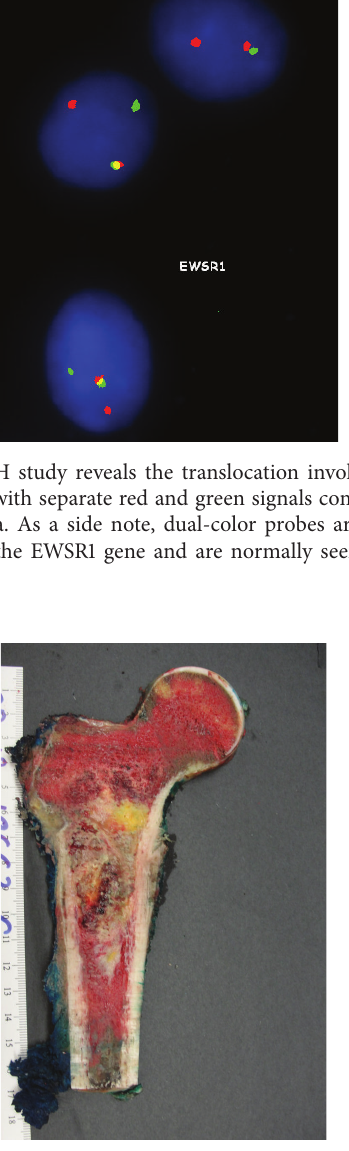
Figure 9: Gross specimen of the right proximal femur with wide resection of the 7.5cm tumor reveals no viable tumor after